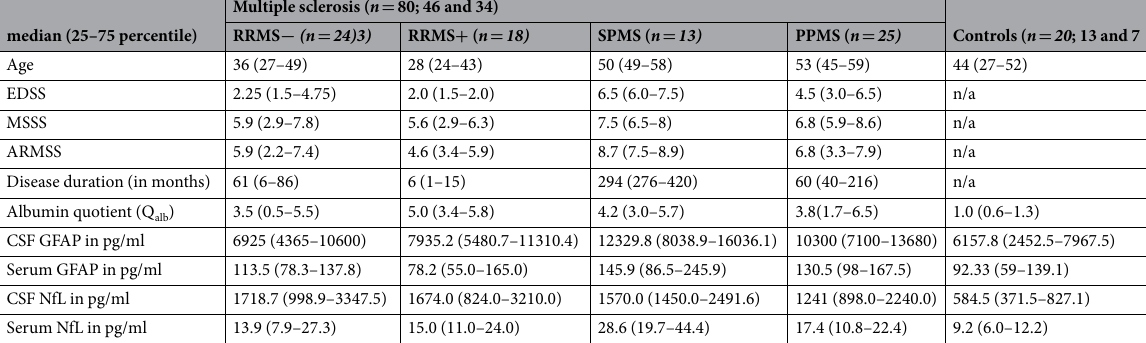
Table 1. Clinical characteristics and biomarker levels in CSF and serum of the included subjects. All given values are median values with the interquartile range in brackets. (25–75 percentile). n = number, ♀ = female, ♂ = male, CSF: cerebrospinal fluid, RRMS-: relapsing-remitting multiple sclerosis between relapse, RRMS + : relapsing-remitting multiple sclerosis during acute exacerbation, SPMS: secondary progressive multiple sclerosis, PPMS: primary progressive multiple sclerosis, n/a: not applicable. EDSS: expanded disability score